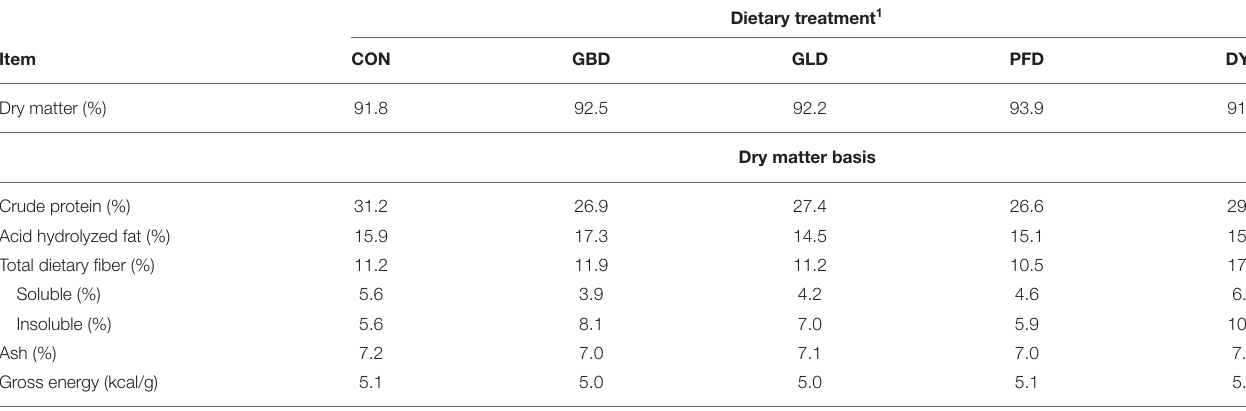
TABLE 2 | Analyzed chemical composition and energy content of canine diets containing legumes or yeast.